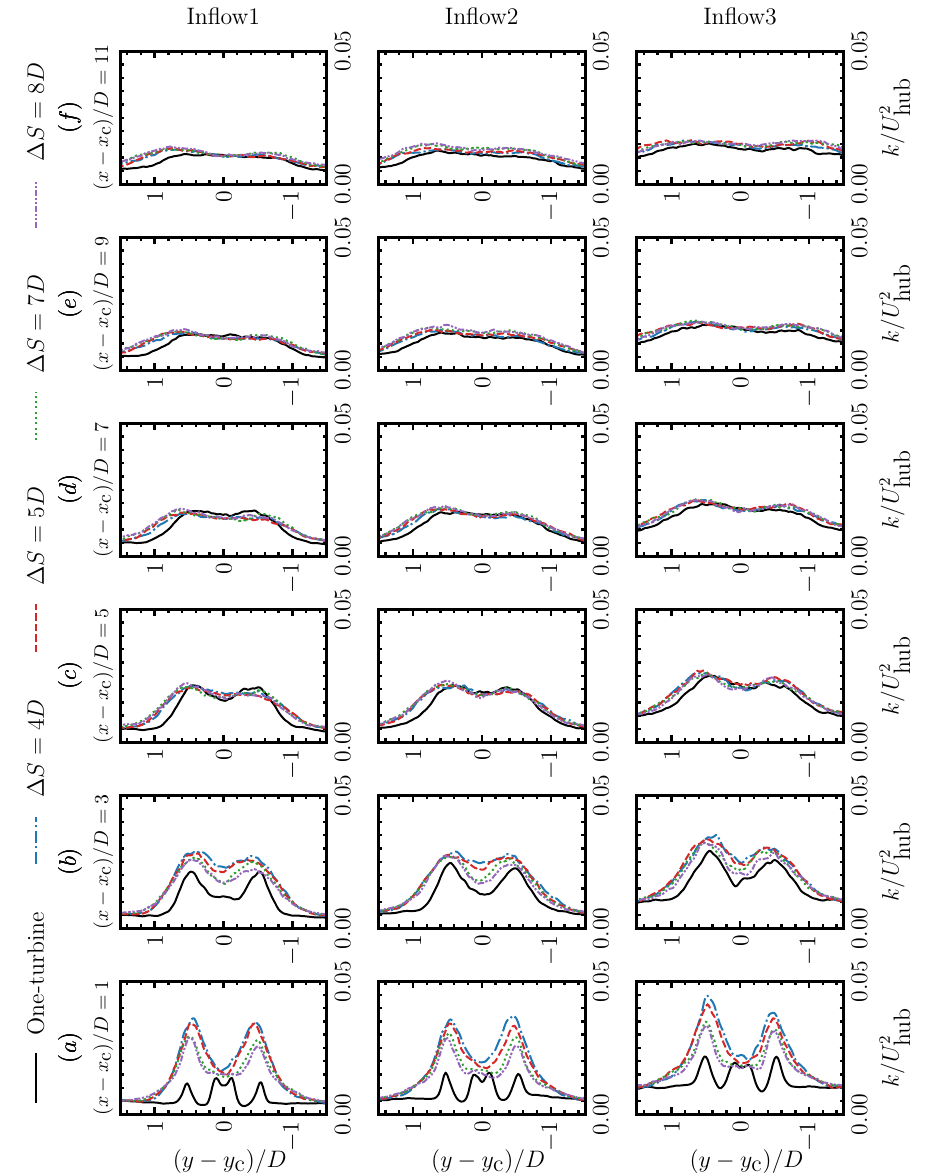
Figure 8. Spanwise profiles of the turbulence kinetic energy downwind of the second turbine of the two-turbine cases and downwind of the stand-alone turbine at ( a ) ( x ( e ) 9, ( f )